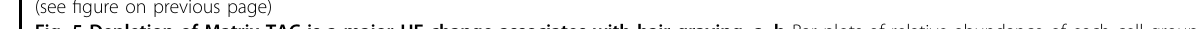
Fig. 5 Depletion of Matrix TAC is a major HF change associates with hair graying. a , b Bar plots of relative abundance of each cell group between white hsHFs and their black neighbors in ( a ) F62 and ( b ) F31 samples. The comparisons were normalized to the total cell numbers of each sample. For example, the F62 IBL bar represents (IBL % in F62B)/(IBL % in F62W). The same applies to all similar fi gures below. c UMAP plots showing the subgroups of proliferating (PR) cells in black (F62B + F31B) and white (F62W + F31W) HFs. d Bar plots of noMxTA and MxTA cell % in all HF epithelial cells in each sample. Numbers indicate exact %. e , f Summary of GSEA analysis result for enriched MSigDB hallmark terms in the F62W-vs- F62B, F31W-vs-F31B gene expression changes in (e) MxTAs or (f) qHFSCs (S1 + S2). F62W up-regulated terms are displayed. g, h Representative ( n = 5 HFs from 3 individuals) whole mount IF ( g ) or white- fi eld ( h ) images of black and grey hsHFs from the same individuals. Scale bars: 200 μ m for g , 500 μ m for h. Dashed lines label different parts of the HFs. i Size quanti fi cation of whole HF and its different parts as labeled on (h) fi gure images. ( n = 25 HF from 3 individuals). j Representative ( n = 5 pairs of black and white HFs from 3 individuals) IF images of human black and white HF sections from the same individuals. Scale bars: 200 μ m. k Left: Representative ( n = 5 pairs of black and white HFs from 3 individuals) IF images of human black and white HF matrix sections from the same individuals. Scale bars: 100 μ m. Right: Quanti fi cation of positive cell % for each of the indicated staining markers in the left